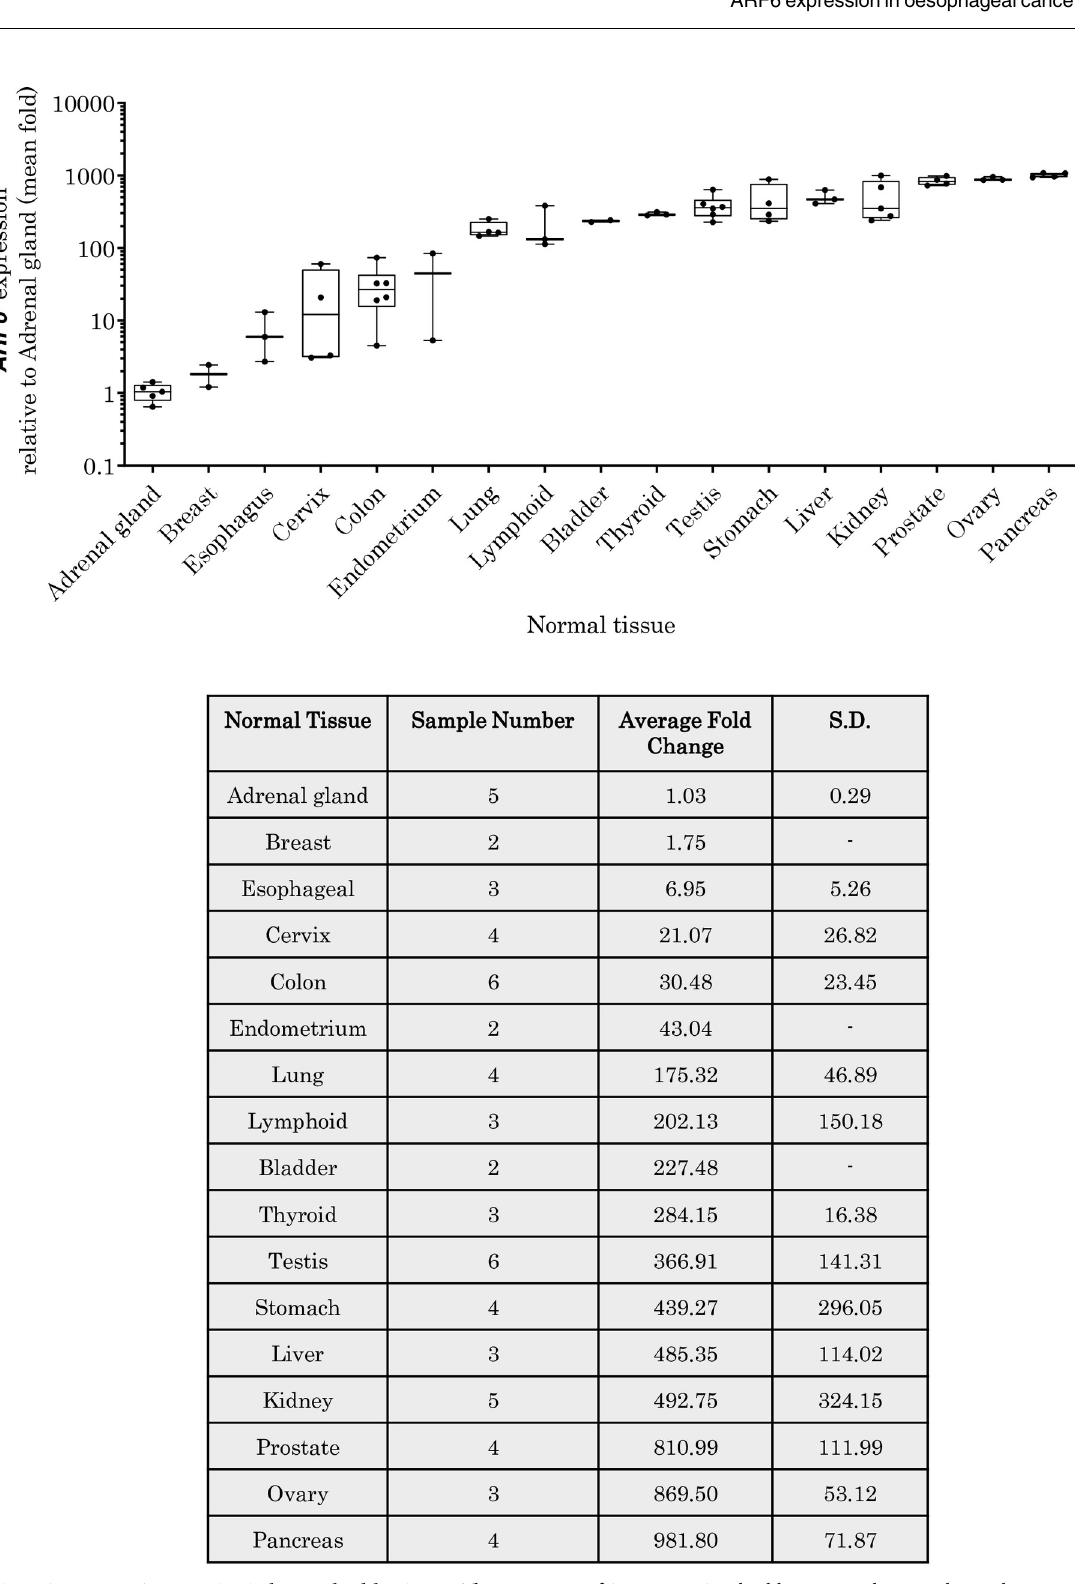
PLOS ONE | https://doi.org/10.1371/journal.pone.0263845 February 10,